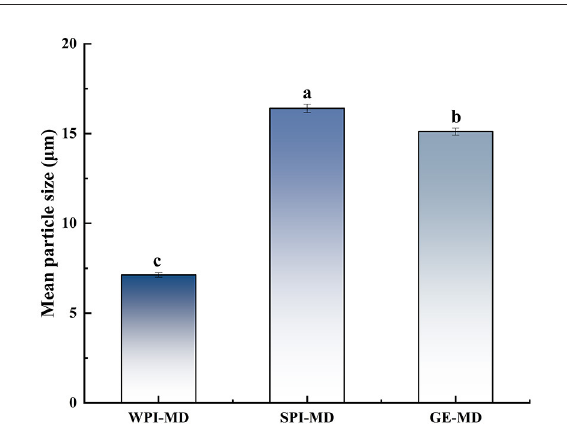
FIGURE1 Mean particle size of microcapsules. Different superscript letters in the graph indicate significant differences between means ( P < 0.05).